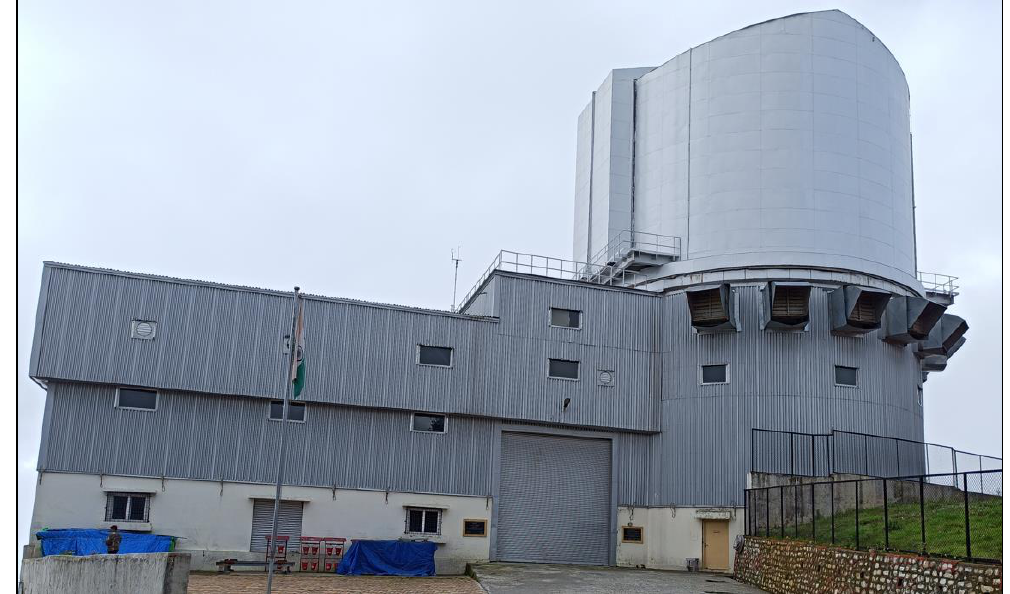
Figure 1. A view of 3.6 m Telescope